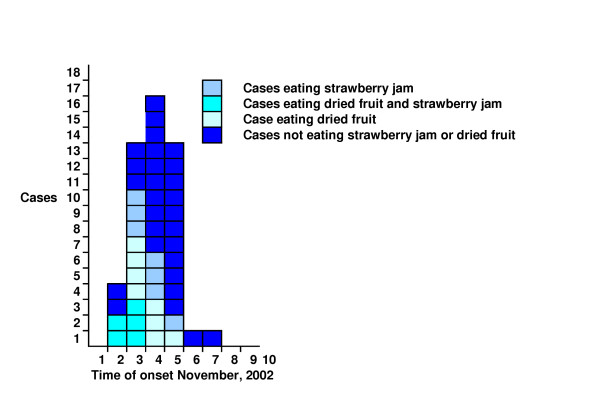
Gastro-enteritis cases (n = 48) by date of onset and exposure to dried fruit and strawberry jam among Nordic patients and employees (n = 91) in a health centre in Gran Canaria, Spain, October-November 2002.